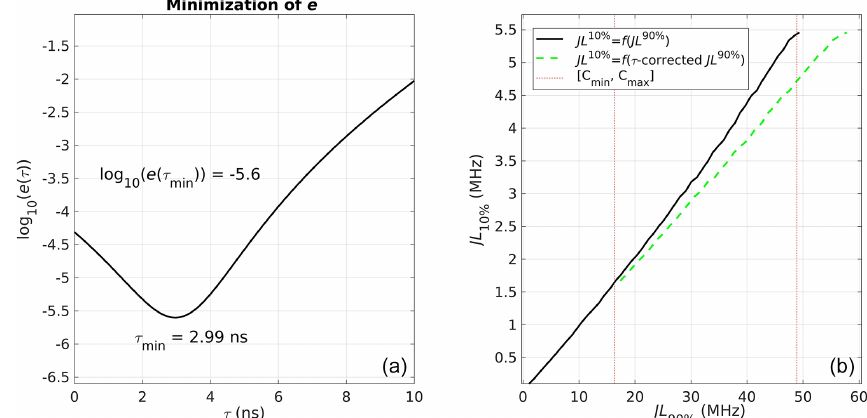
Figure 8. Dead-time calculation and correction of the high-transmission channel J 90% . Panel (a) shows the minimization of the distance vector e(τ i ) in terms of τ i yielding the dead time τ = 2 . 99ns. Panel (b) shows the saturated J 10% = f (J desat (τ = 0 )) (solid black), the desaturated linear relation J 10% = f (J desat (τ min )) (dashed green) and the count-rate domain [ C min ,C max ] (dashed red).